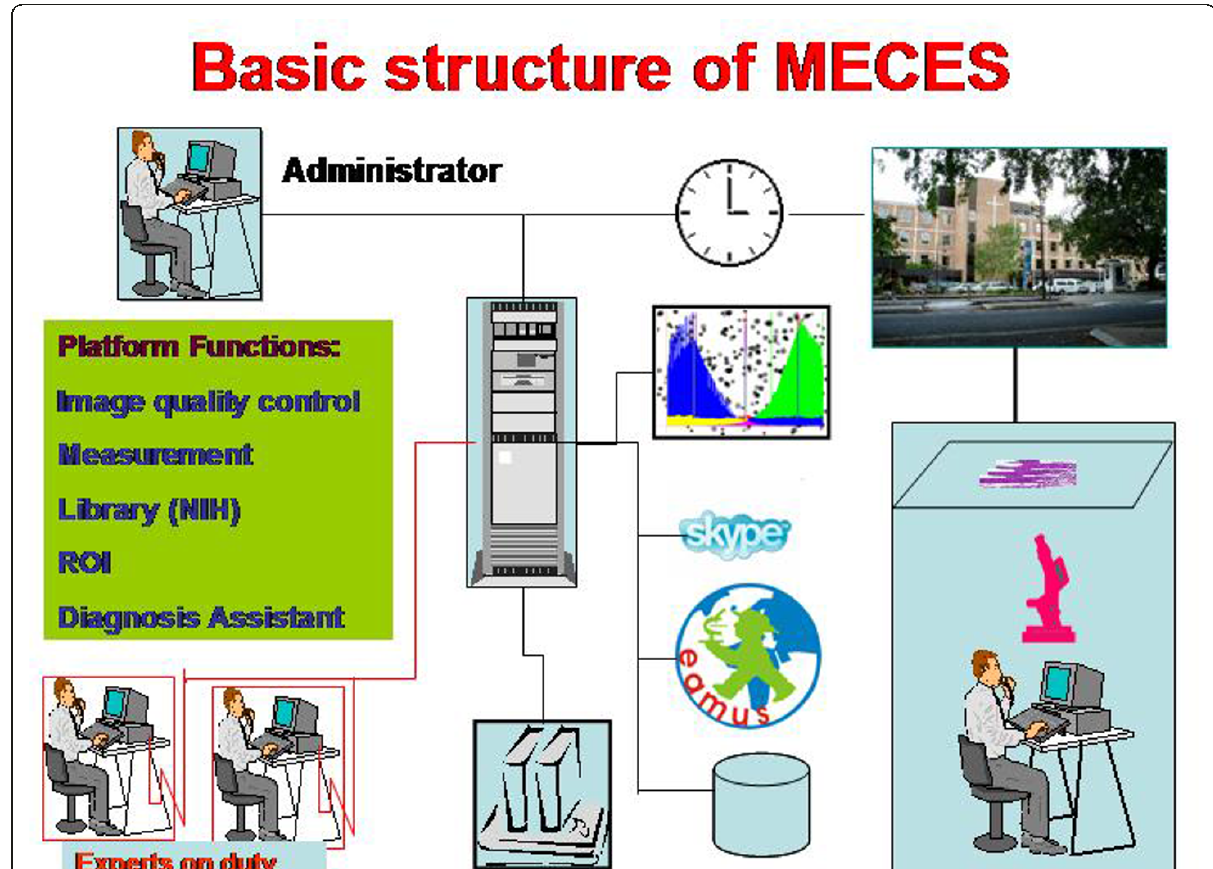
Figure 7 Basic structure of MECES (Medical Electronic Communication Expert System)